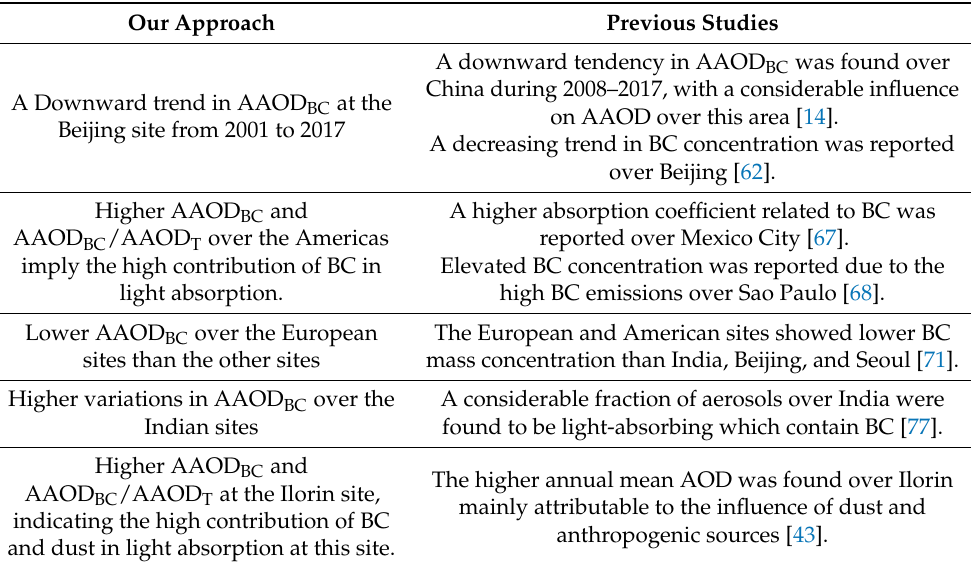
Table 4. Comparison of our AAOD BC retrieval methodology results with previous